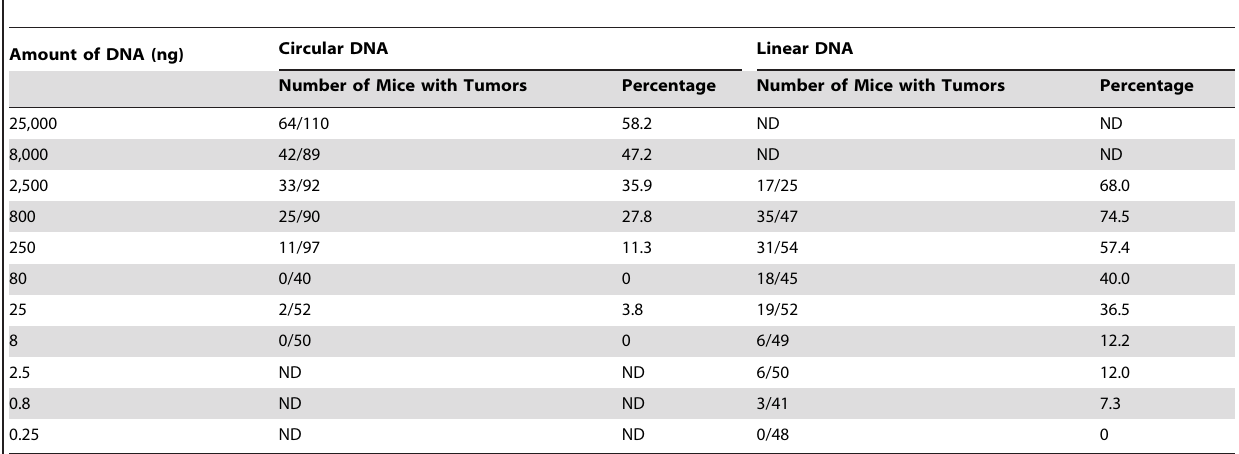
Table 1. Dose-response data in CD3 epsilon mice inoculated with circular or linear pMSV-T24-H- ras /MSV-c- myc .